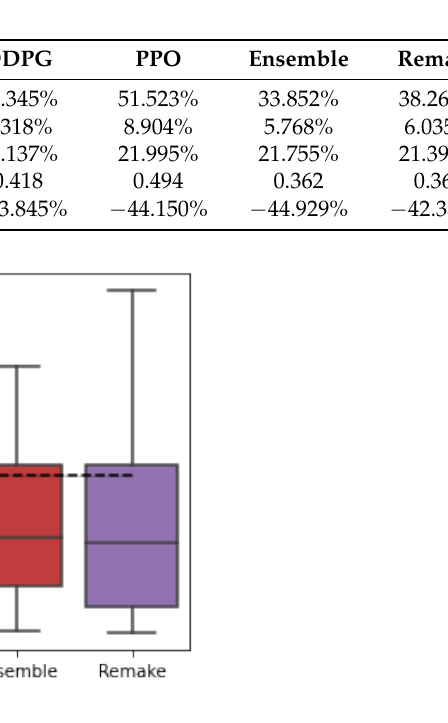
Table 2. Average performance of five RL-based agents on top 30 KOSPI stocks from 4 January 2016 to